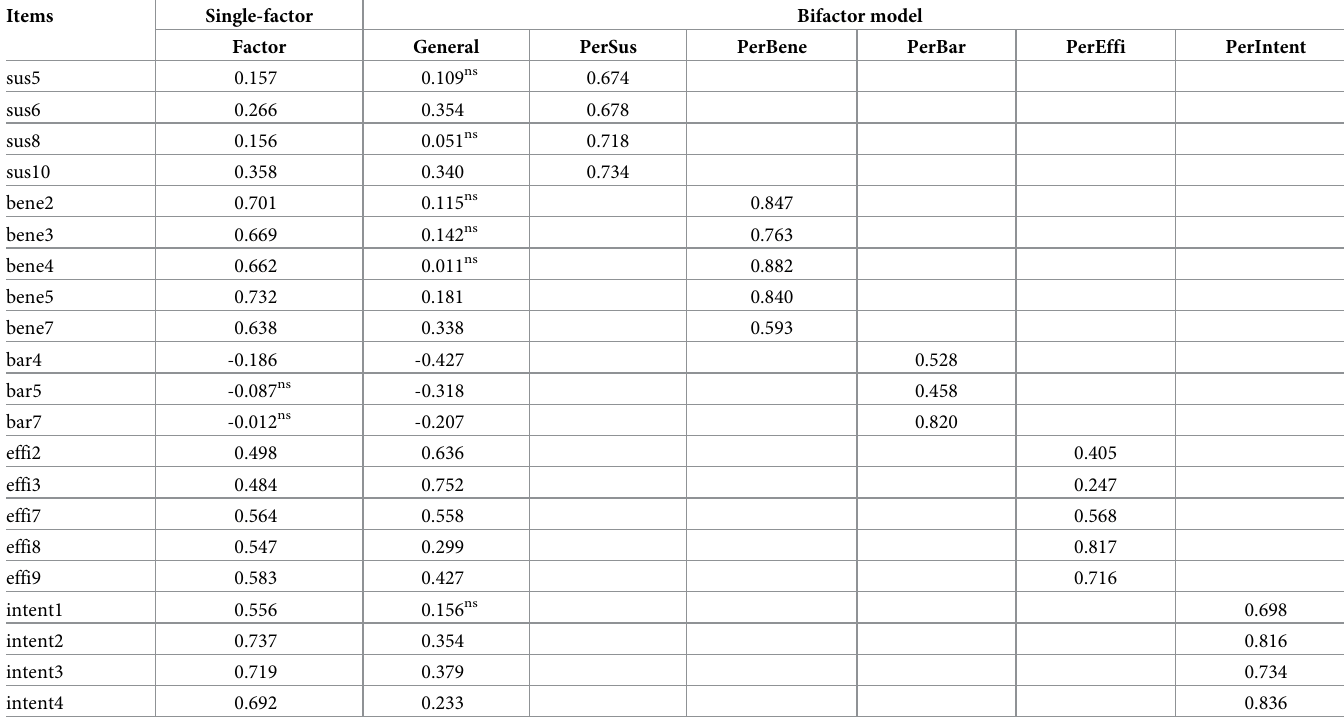
Table 4. Standardized factor loadings of CFA for single-factor and bifactor models.